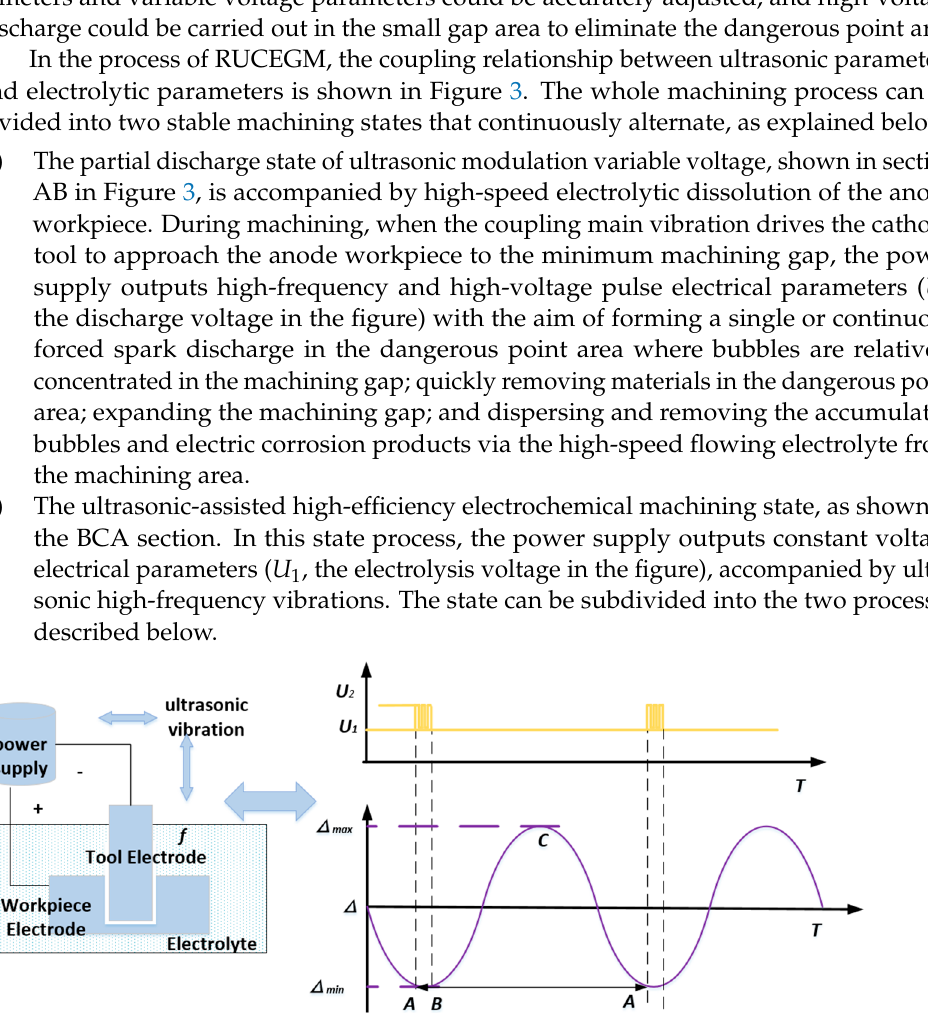
Figure 3. Schematic diagram of synergistic mechanism.